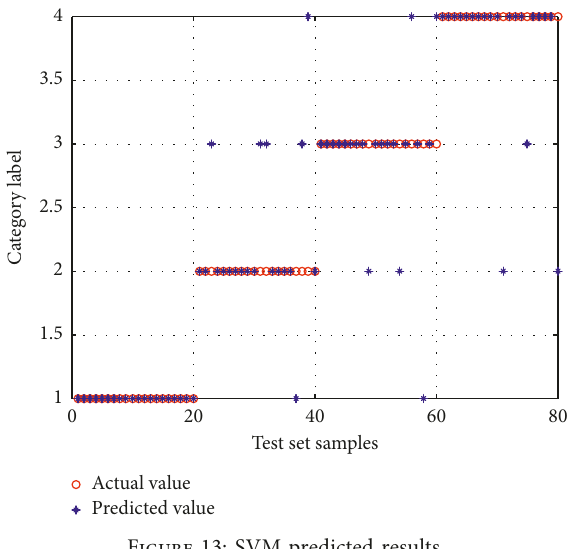
Figure 13: SVM predicted results.